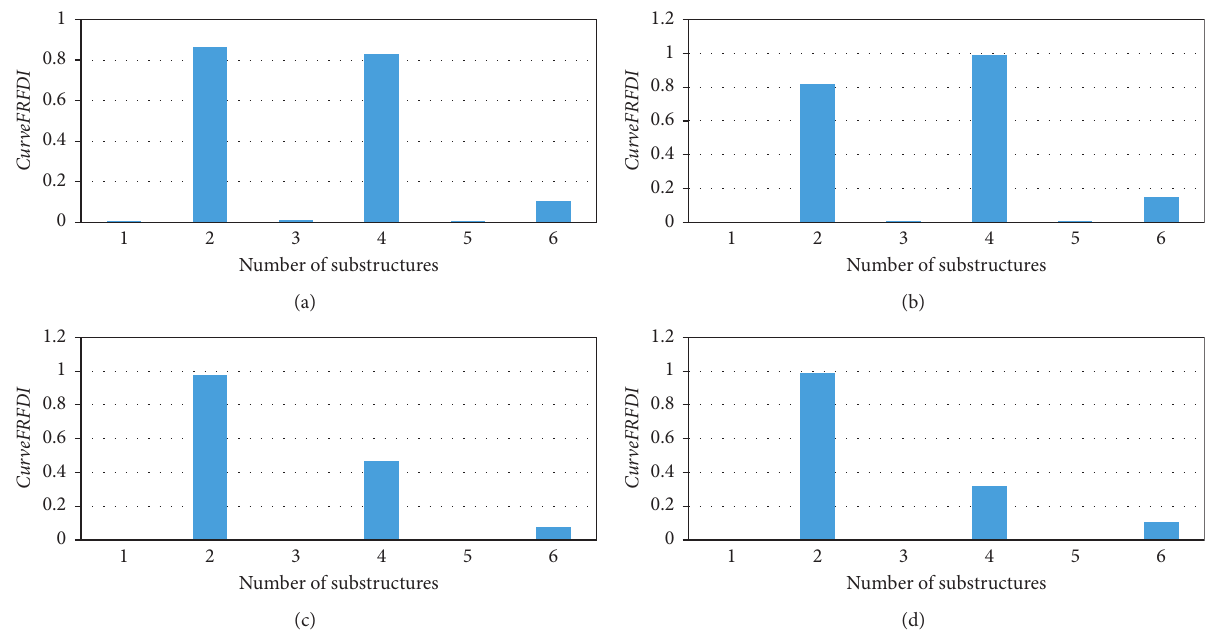
Figure 22: CurveFRFDI values for (a) case Dam_2F10%&4F15%, (b) case Dam_2F10%&4F20%, (c) case Dam_2F15%&4F10%, and (d) case